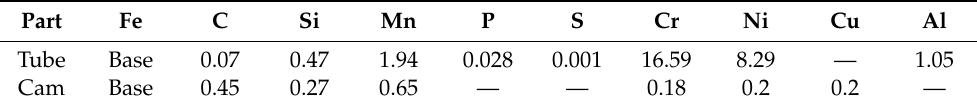
Table 1. Chemical composition of SUS304 tube and 45 steel cam (wt.%).